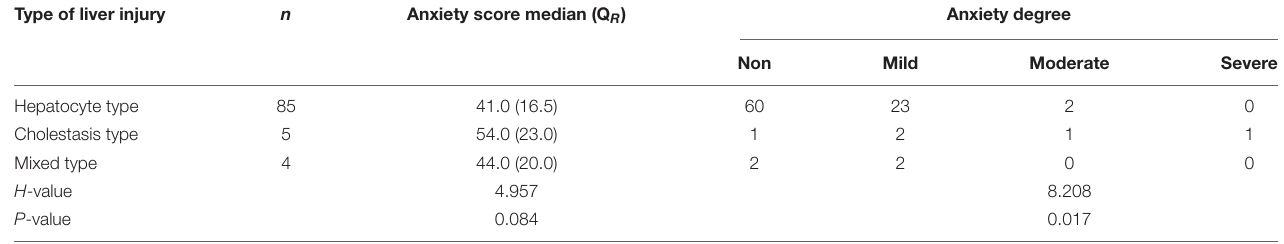
TABLE 4 | Relationship between the type of liver injury and the degree of anxiety.